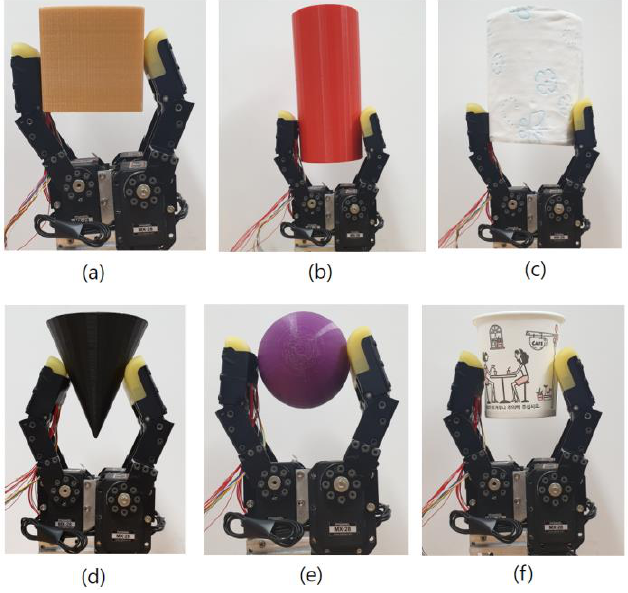
Figure 22. Grasping of various objects ( a – f ).